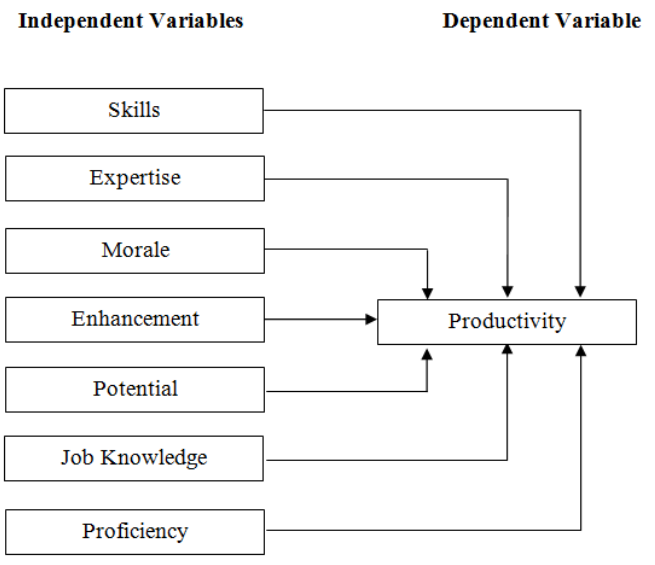
Figure 1: Training and development on